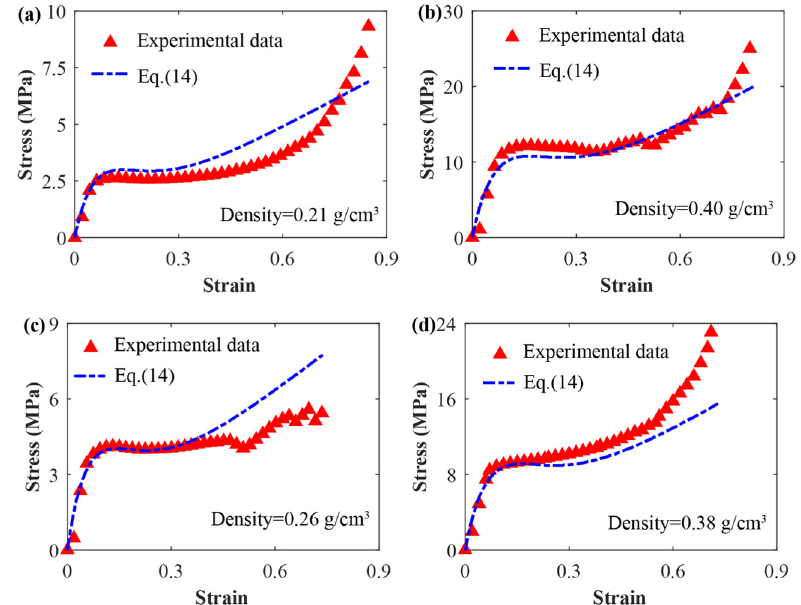
Figure 12: The comparison between the stress – strain curves of TFPU grouting materials obtained by equation ( 14 ) with the experimental ones. The densities of the TFPU grouting materials are: ( a ) 0.21 g · cm − 3 , ( b ) 0.40 g · cm − 3 , ( c ) 0.26 g · cm − 3 . and ( d ) 0.36 g · cm − 3